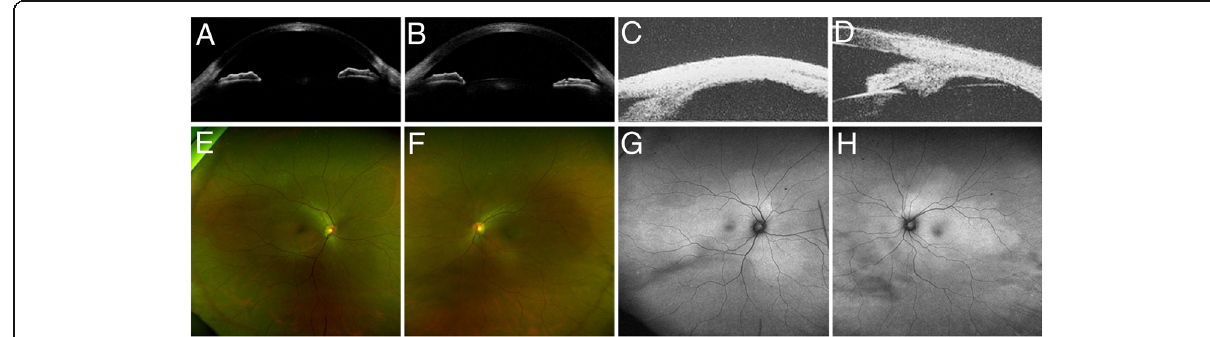
Fig. 4 Findings 7 months after the steroid tapering therapy. a , b Optical coherence tomography findings. a Right eye. b Left eye. The anterior chamber got deeper, and the angle was open in both eyes. The depth of anterior chamber recovered to 3.00 and 2.93 mm in the right and left eyes, respectively. c , d Ultrasound biomicroscopy findings. a Right eye. b Left eye. d The ciliochoroidal detachment in the left eye completely resolved. e , f Fundus photography findings. e Right eye. f Left eye. The multiple serous retinal detachments disappeared in both eyes. g , h